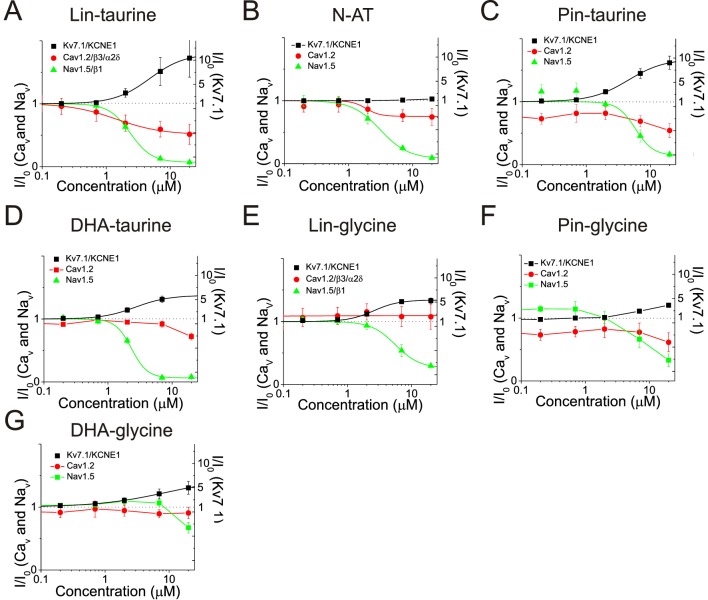
Dose response curves for PUFAs on IKs, ICaL, and INaV at 0 mV.Dose response of IKs, ICaL, and INaV currents (I/I0) at 0 mV for (A) Lin-taurine (Km of IKs = 11.4 ± 0.4 μM; Km of ICaL = 1.4 ± 0.4 μM; Km of INaV = 2.4 ± 0.04 μM; mean ± SEM), (B) N-AT (Km of IKs = NA; Km of ICaL = 2.5 ± 1.9 μM; Km of INaV = 3.1 ± 0.3 μM; mean ± SEM), (C) Pin-taurine (Km of IKs = 4.5 ± 0.2 μM; Km of ICaL = NA; Km of INaV = 5.8 ± 1.7 μM; mean ± SEM), (D) DHA-taurine (Km of IKs = 5.9 ± 0.3 μM; Km of ICaL >20 μM; Km of INaV = 2.3 ± 0.1 μM; mean ± SEM), (E) Lin-glycine (Km of IKs = 5.4 ± 0.2 μM; Km of ICaL = NA; Km of INaV = 5.6 ± 0.5 μM; mean ± SEM), (F) Pin-glycine (Km of IKs > 20 μM; Km of ICaL = NA; Km of INaV >20 μM; mean ± SEM), and (G) DHA-glycine (Km of IKs > 20 μM; Km of ICaL = NA; Km of INaV >20 μM; mean ± SEM),.